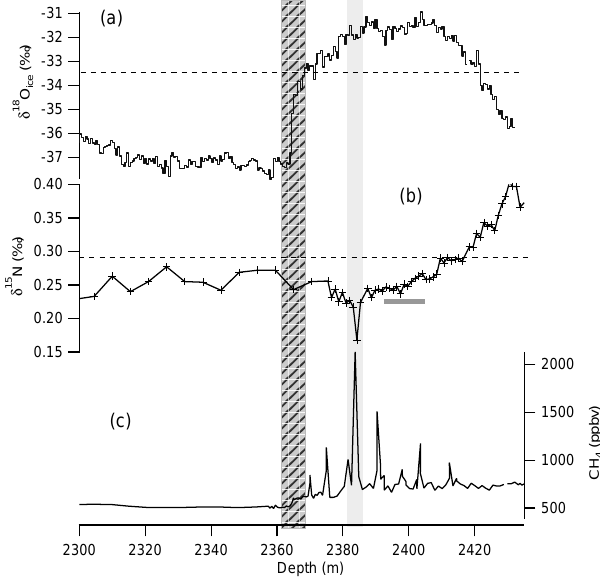
Figure 2. NEEM δ 18 O ice (top), δ 15 N (middle) and CH 4 (bottom) spanning the LIG. The hatched rectangle indicates the stratigraphic disturbance identified in the upper part of the LIG section. The light grey rectangle highlights the single negative peak in δ 15 N at NEEM during the LIG, corresponding to the strongest positive peak in CH 4 , both peaks being identified at 2384m depth. The grey and bold horizontal segment indicates the depth range over which the δ 15 N average has been